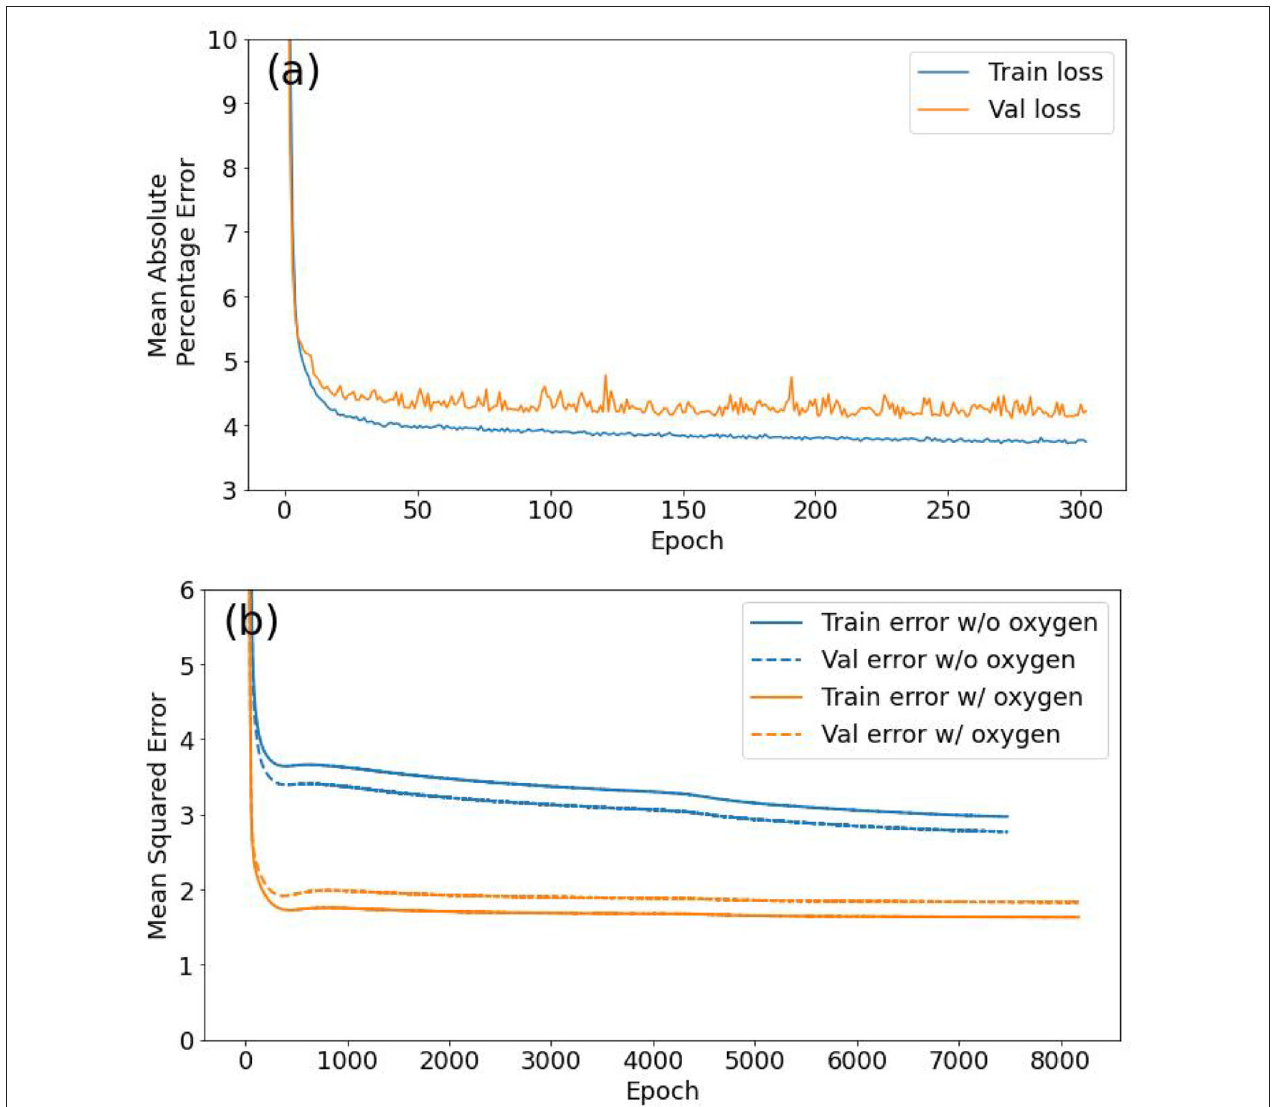
FIGURE 4 | (a) Oxygen model training, showing the reduction of the mean absolute percentage error (loss) as a function of epochs (302 in total). Losses over both training (blue) and validation (orange) datasets are shown. (b) Comparison of training history of two different nitrate models: first without oxygen as an additional feature variable (blue lines), and second with oxygen as an extra feature (orange lines). Both the training (solid) and validation (dashed) losses are shown. An epoch is a single pass through all training